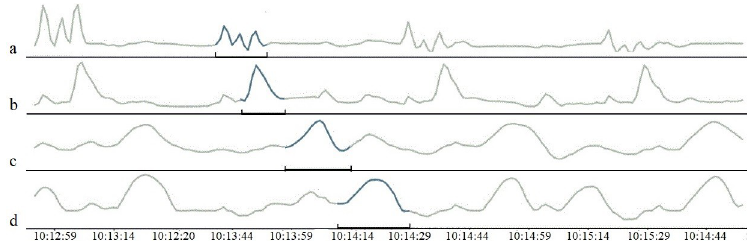
Fig 3. Pressure measured at four locations of the forestomach of a cow during rumination. (a) reticulum; (b) cranial ruminal sac; (c) dorsal blind sac; (d) ventral ruminal sac. The A-wave is highlighted in this figure and moves chronologically over the different